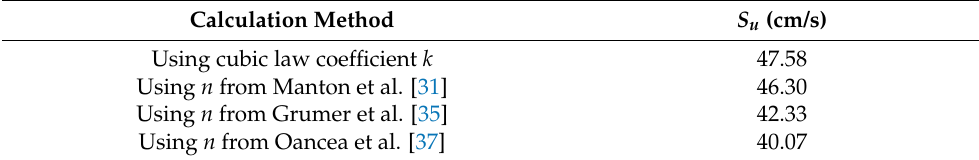
Table 6. Laminar burning velocities of CH 4 -N 2 O mixture with stoichiometric composition diluted with 40 vol% N 2 , at ambient initial temperature and